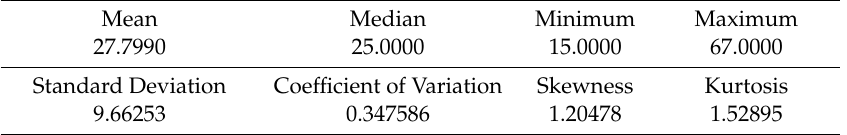
Table 2. Descriptive statistics—for observations from sample N = 1159 for the age variable.